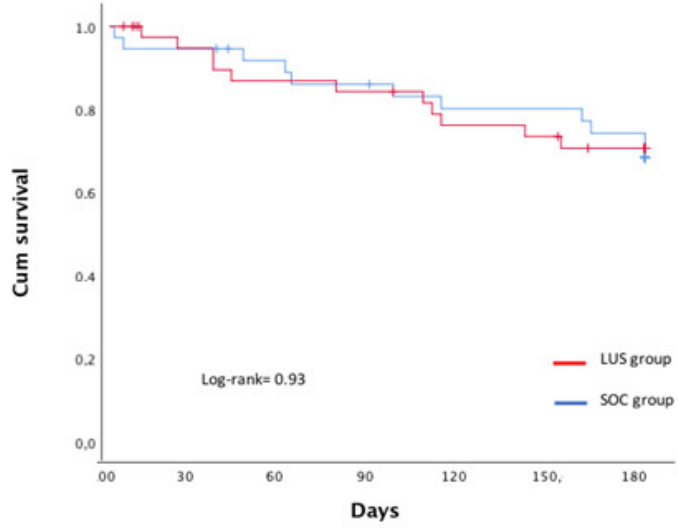
Figure 2. Survival analysis between the two arms at the EPICC trial.